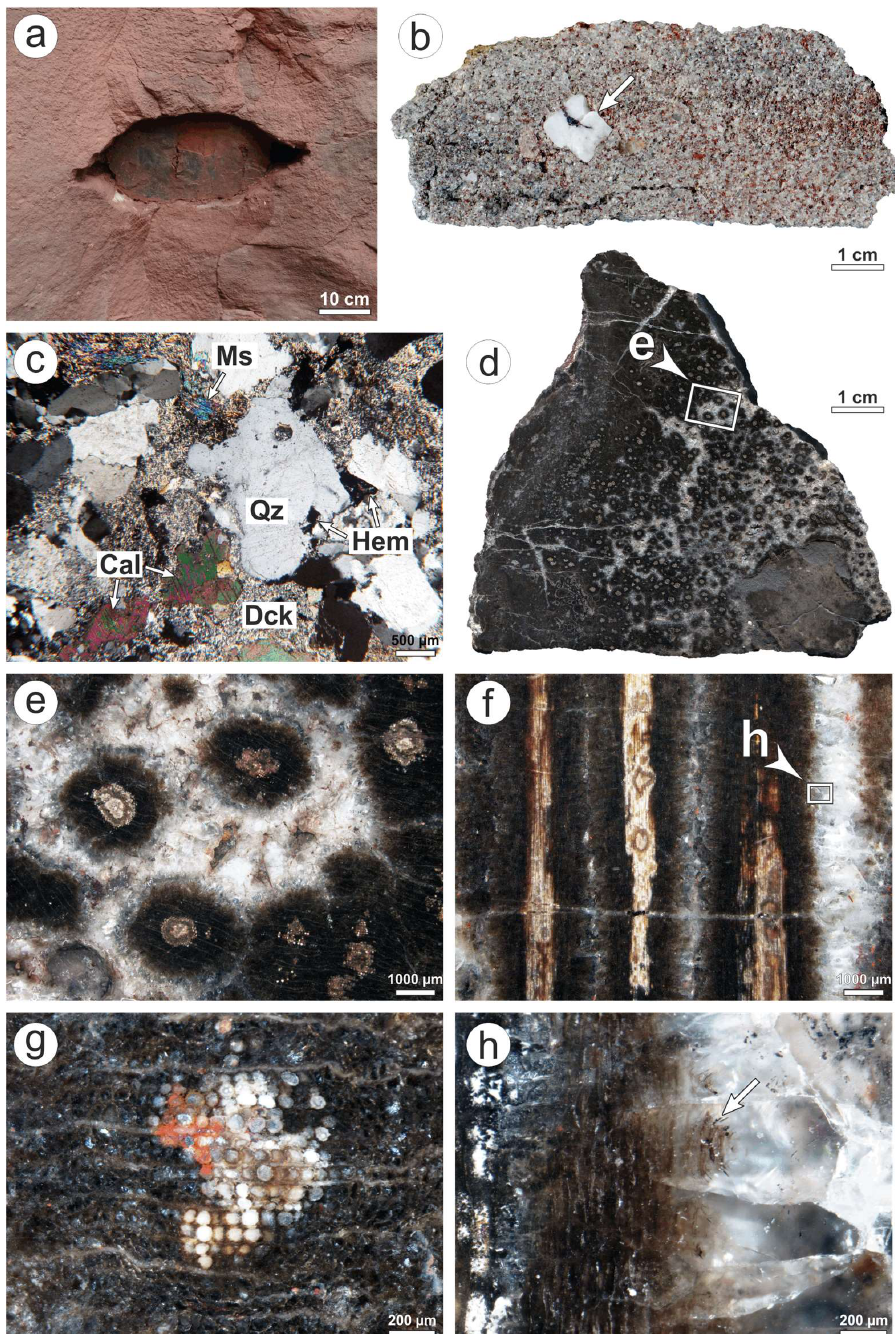
Figure 10. Features of K2097 and its host rock from the Kyffhäuser. ( a ) Appearance of logs in the field: cross-cut of a log horizontally embedded in medium-grained sandstones. Note vertical compaction by oval geometry of the cross-cut. ( b ) Typical reddish white kaolin sandstones of the Siebigerode Fm. The log-bearing fine- to medium-grained sandstones are mostly well sorted and only contain rarely pebbles (arrow). ( c ) XPL image of B showing the mineralogical composition of the sandstones: quartz (Qz) and muscovite (Ms) as detrital grains, whereas intergranular space is filled by dickite (Dck), calcite (Cal) and hematite (Hem) in order of decreasing abundance. ( d ) Cross-cut of silicified Agathoxylon -type wood preserved as “pointstone”. ( e ) Close-up of the “points”. ( f ) “Pointstone” preservation in longitudinal section revealing a tube-like or spheroidal geometry. ( g ) Center of a “point” in cross-section. Note the increasing deformation from the center outwardly. ( h ) Close-up of F showing large quartz blades, which incorporate plastically deformed wood cells.